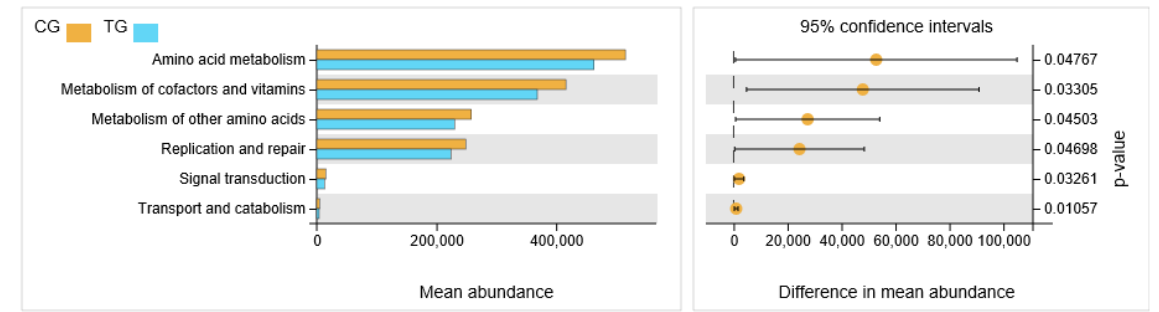
Figure 5. The differences of presumptive biological function of cecal contents microflora between the control group and the treatment